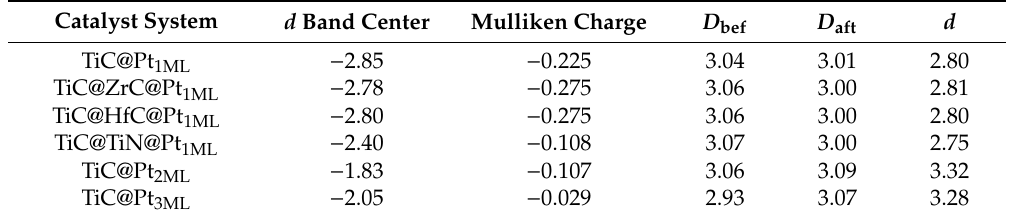
Table 2. The d band center and the Mulliken charge of the Pt surface atom. D bef and D aft stand for the average bond length of the surficial Pt–Pt bonds before and after OH adsorption while d is the Pt–Pt bond length underlying the OH species.